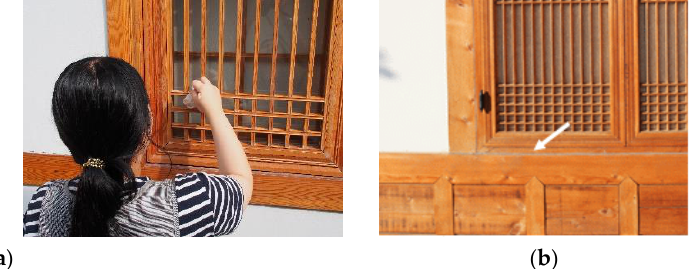
Figure 10. Current situation for Hanok maintenance performed on the site. ( a ) Ordinary manual maintenance; ( b ) Fixing fissures using silicon.